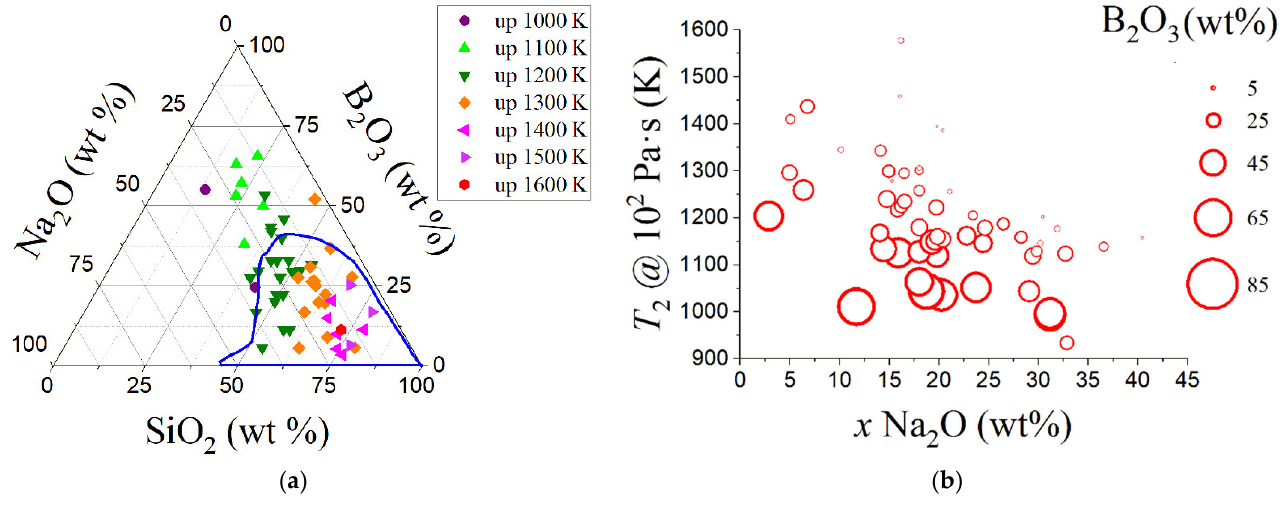
Figure 10. ( a ) Ternary diagram of selected sodium borosilicate glasses from Sciglass TM database (version 7.9). The blue region corresponds to approximately the T 2 behavior from a plethora of sodium borosilicate waste-immobilization glasses. ( b ) The temperature dependence of viscosity fixed at 10 2 Pa · s on sodium oxide content. The temperature in which viscosity reaches 10 2 Pa · s ( T 2 ) shows a similar trend observed for the liquidus temperature when the addition of sodium oxide diminishes T 2 . It was also observed that the decrease in boron oxide follows an increase in T 2 for a fixed sodium oxide content.